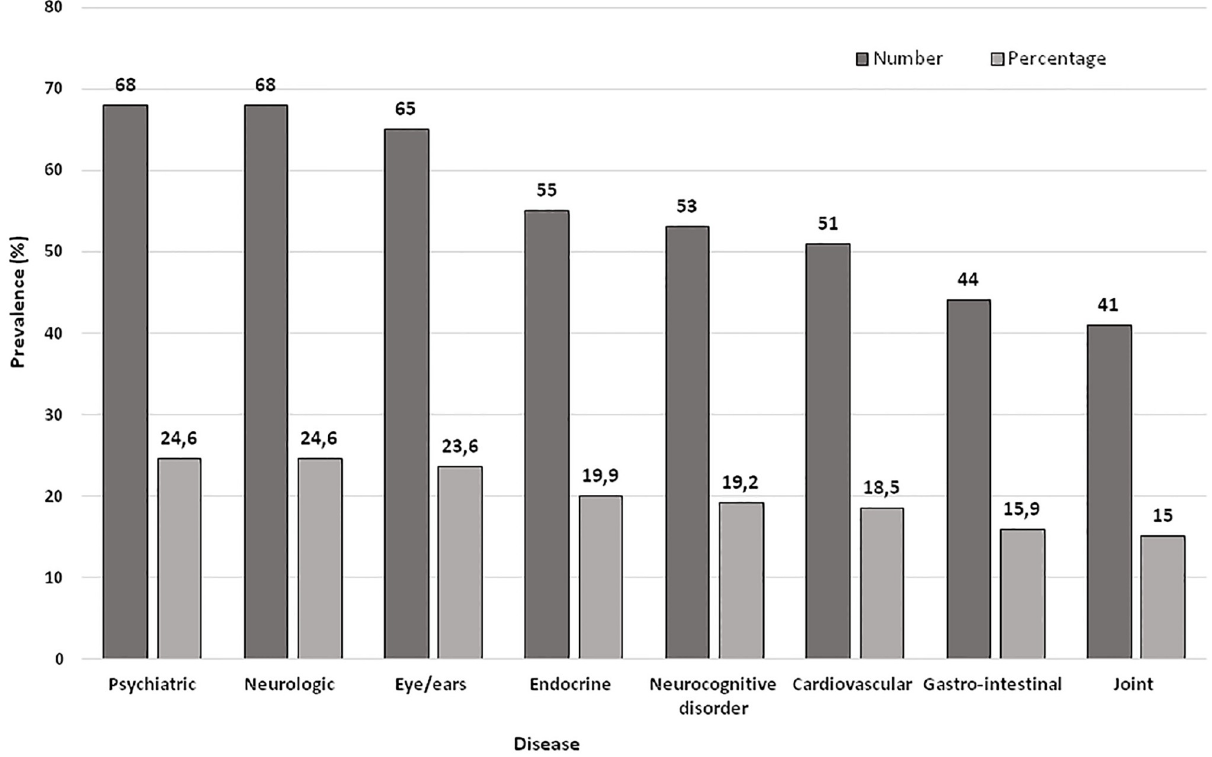
Fig 2. Concurrent health conditions superimposed on ID in descending order of prevalence. Psychiatric disease: certified psychiatric comorbidity ( e . g ., psychosis, schizophrenia, autism spectrum disorder, personality disorder, depression); Neurologic disease: cerebral palsy, spina bifida, acute brain stroke, peripheral neuropathy, etc.; Neurocognitive disorder: primary or secondary neurocognitive disorders according to Silverman et al.’s classification [26]; Cardiovascular disease: heart diseases, hypertension, haematological and vascular diseases; Gastrointestinal disease: diseases both of the upper and inferior digestive tract.